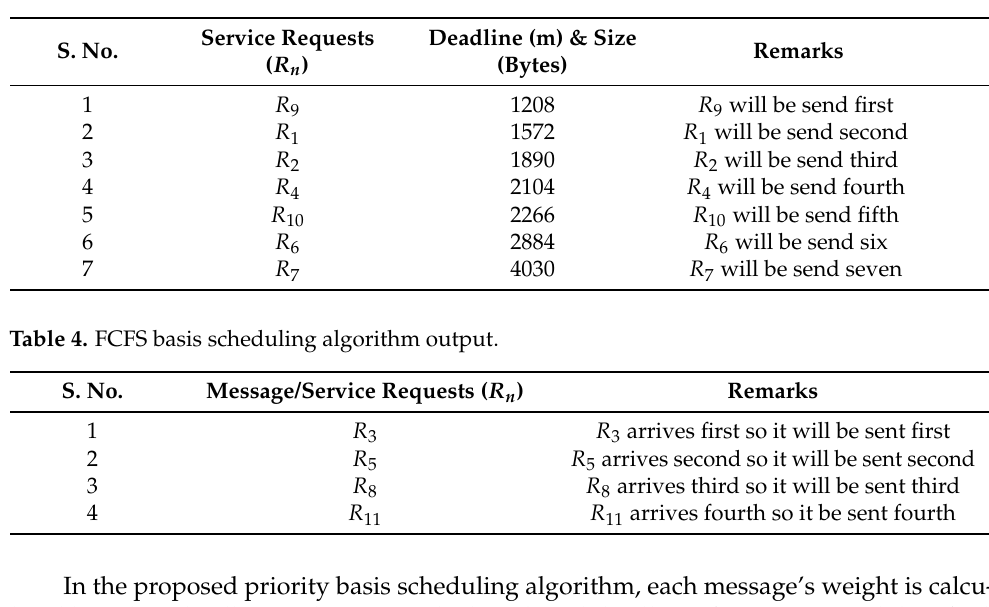
Table 3. Priority basis scheduling algorithm output in ascending order.